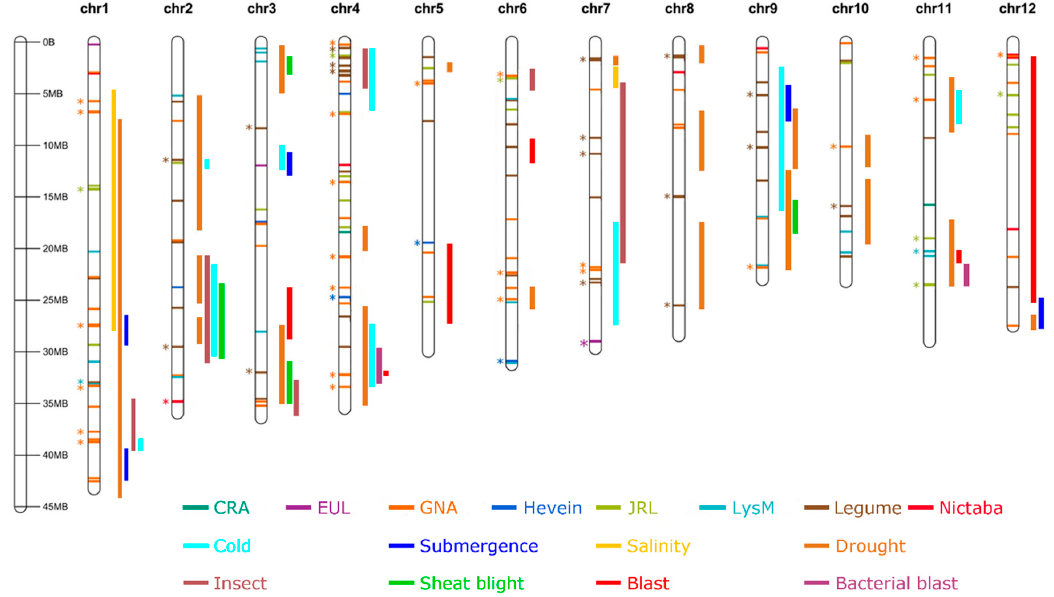
Figure 1. Localization of lectin genes and quantitative trait loci (QTLs) for resistance/tolerance on rice chromosomes of O. sativa spp. japonica. Lectins are indicated by horizontal bars inside the chromosomes, and are shown in distinct colors. Tandem duplicated blocks are indicated by asterisks. QTLs are indicated by vertical bars next to the chromosomes, represented in different colors.